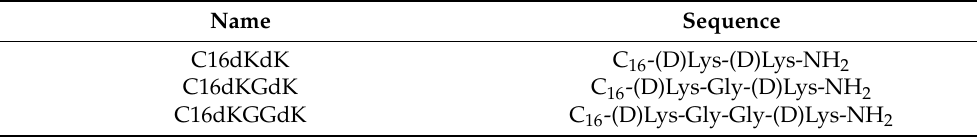
Table 1. The sequence of the synthetic